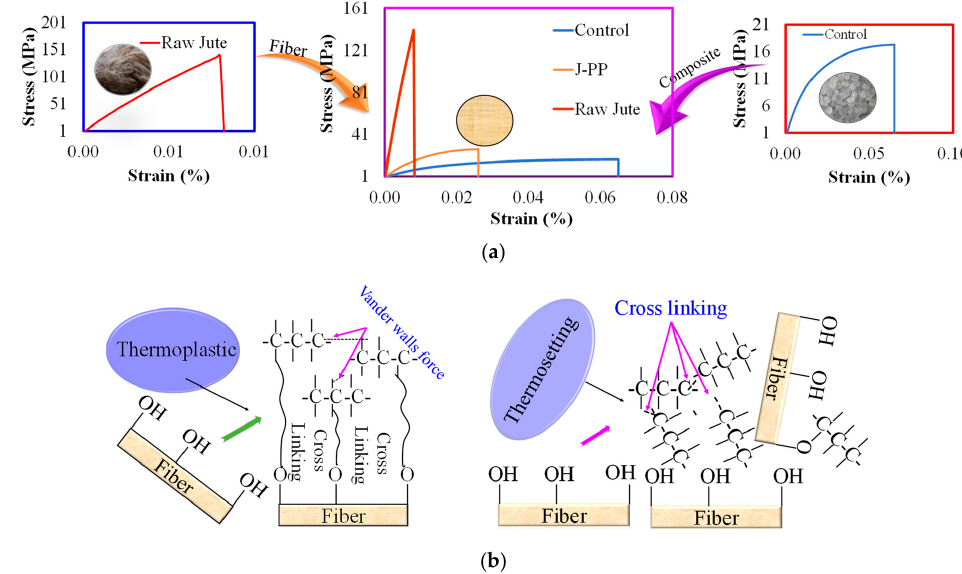
Figure 13. ( a )Effect of the fiber in the matrix materials ( b ) cross-linking between the fiber and